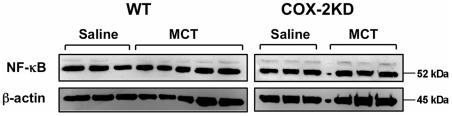
NF-κB expression in lungs is unchanged after MCT.Representative immunoblot for NF-κB p52 subunit with β-actin normalization in WT and COX-2 KD whole lung homogenates. WT/saline, n = 6; WT/MCT, n = 11; COX-2 KD/saline, n = 6; COX-2 KD/MCT, n = 7.